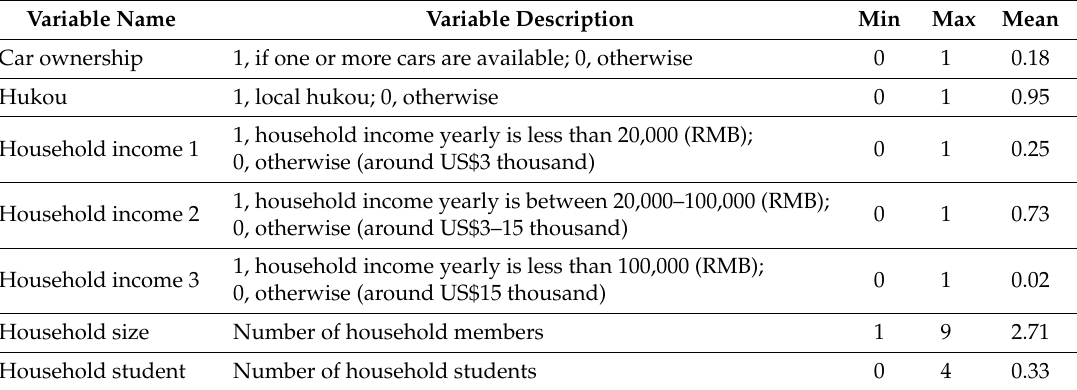
Table 1. Descriptive statistics of socio-economic and travel-related